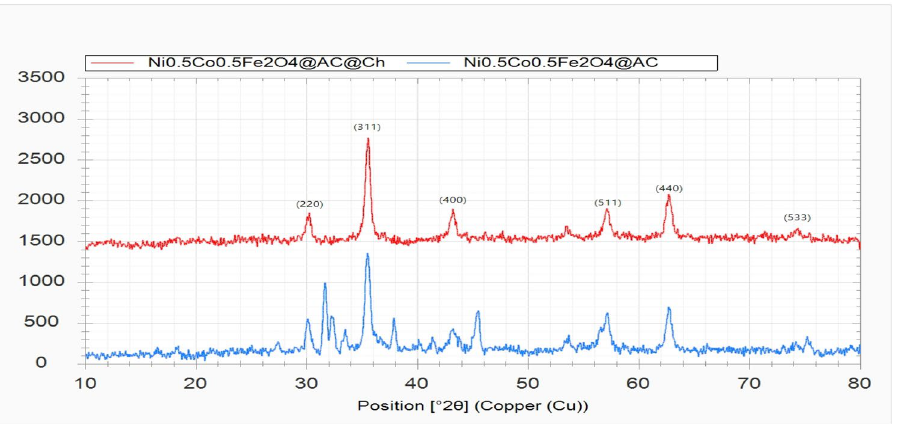
Figure 5. Comparison of X-ray diffraction patterns of Ni 0.5 Co 0.5 Fe 2 O 4 /AC and Ni 0.5 Co 0.5 Fe 2 O 4